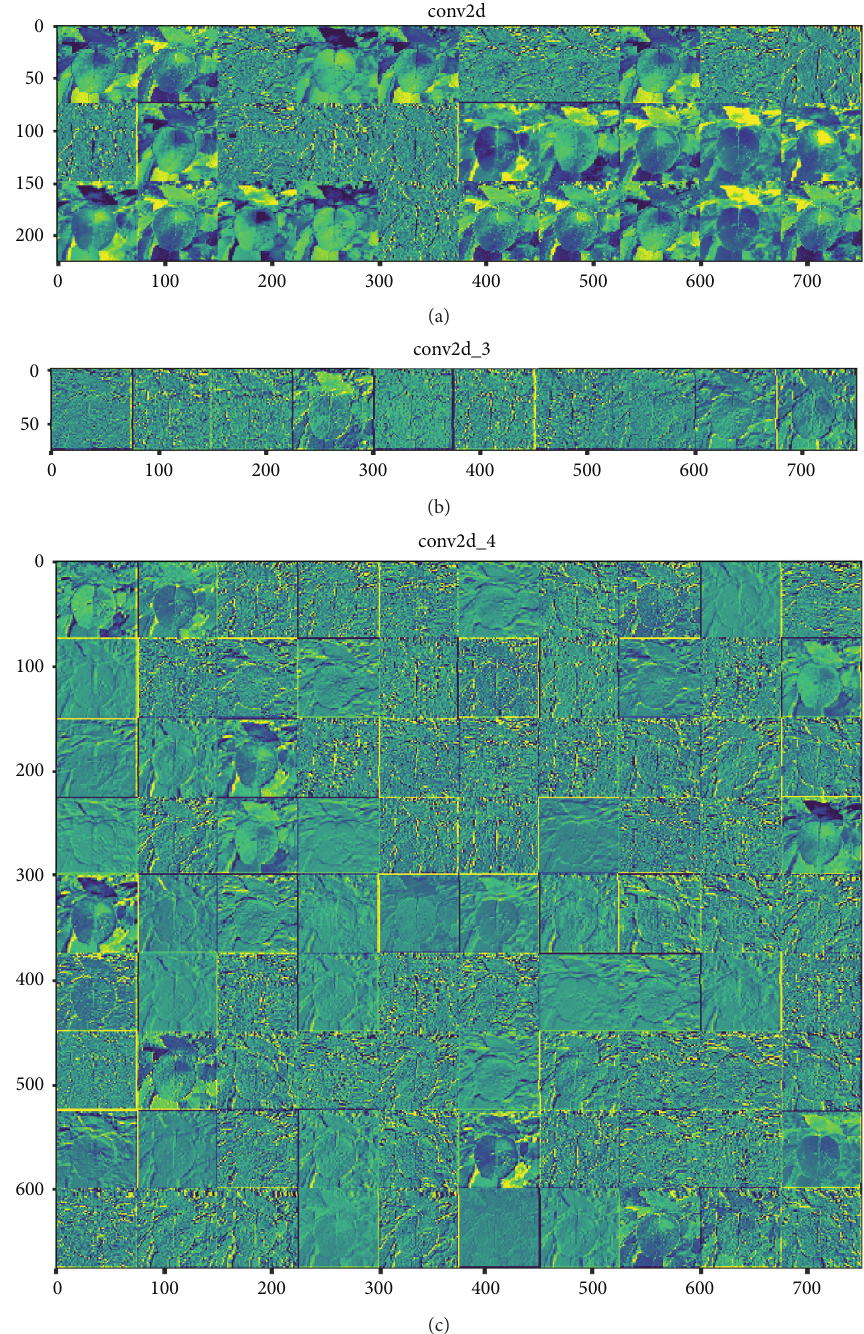
Figure 6: The outputs of the first blocks of convolutional layers of the EfficientNet